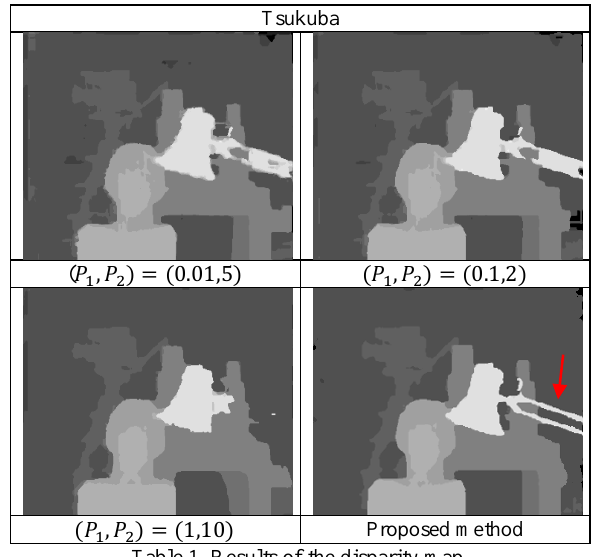
Table 1. Results of the disparity map.